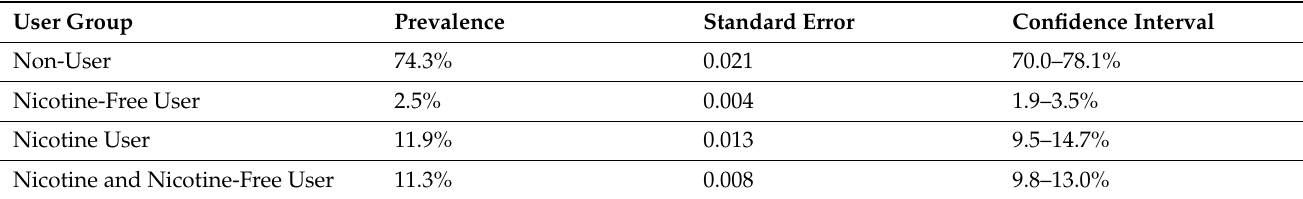
Table 2. Weighted prevalence of vape